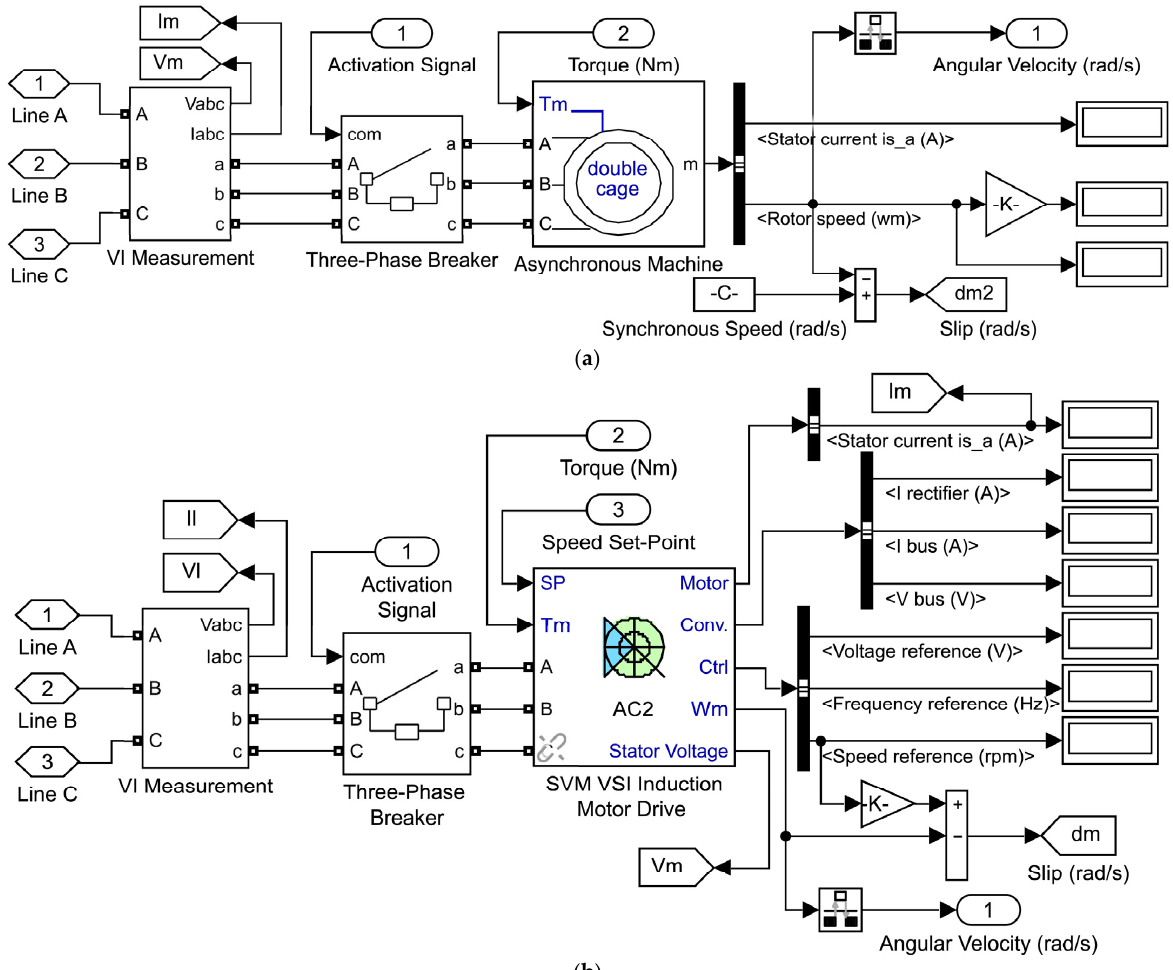
Figure 9. Simulink models of the three-phase induction motor with its drives and meters: ( a ) with a direct connection to the grid at nominal speed; ( b ) with variable speed drive.